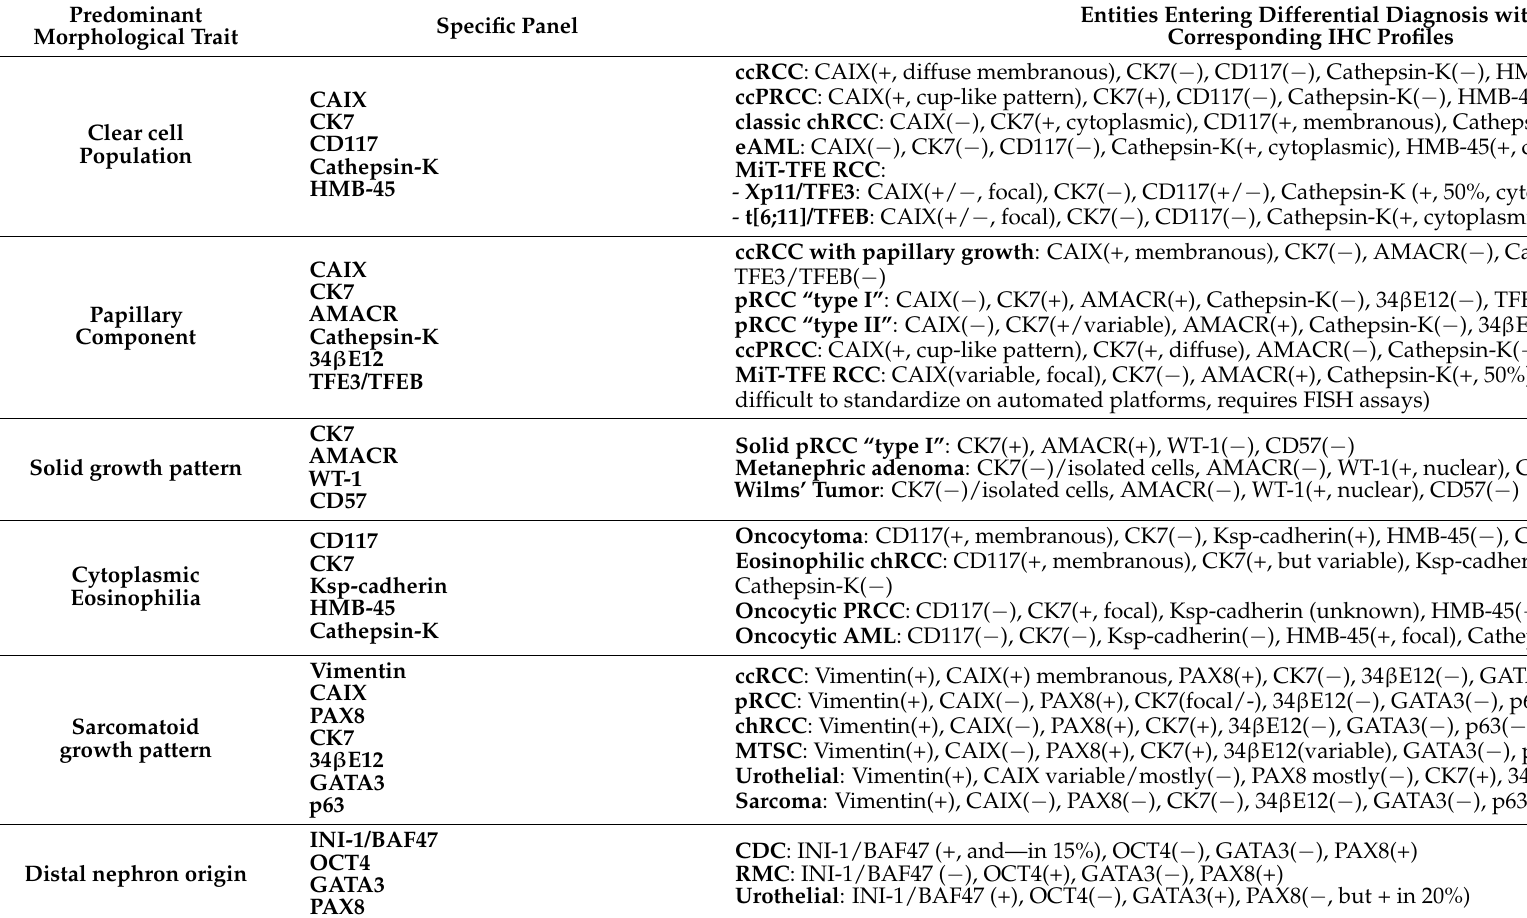
Table 2. Differential diagnosis-driven IHC panels and profiles for morphological RCC traits